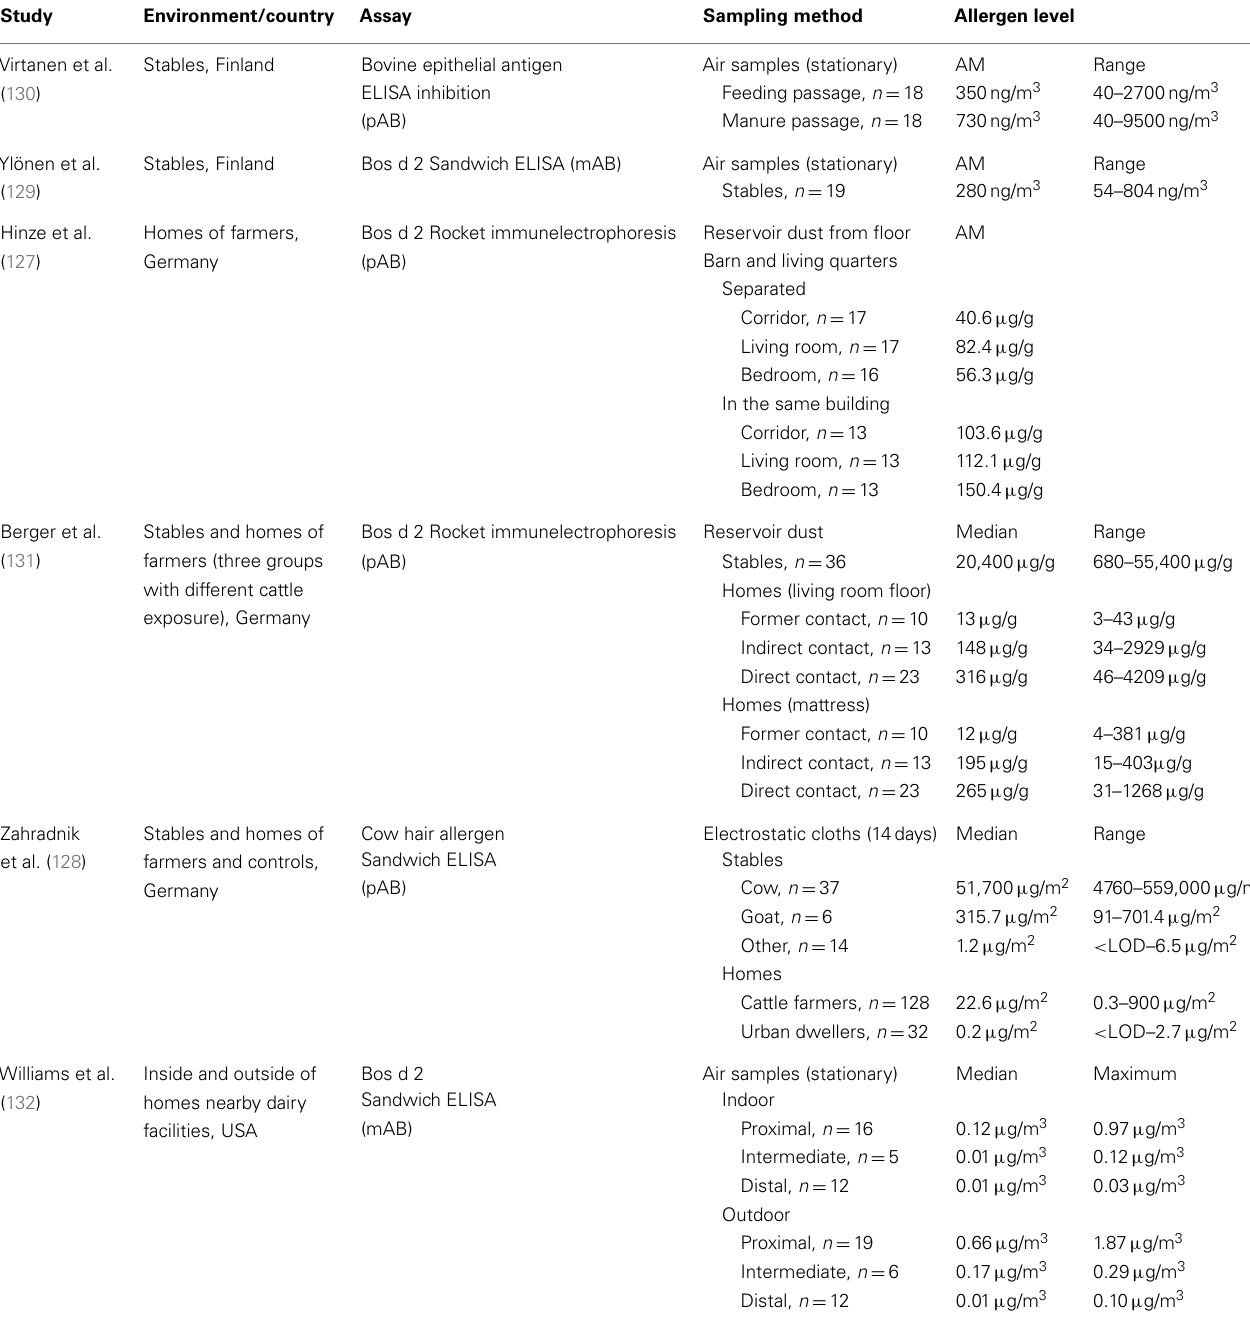
Table 6 | Studies related to exposure assessment to cattle